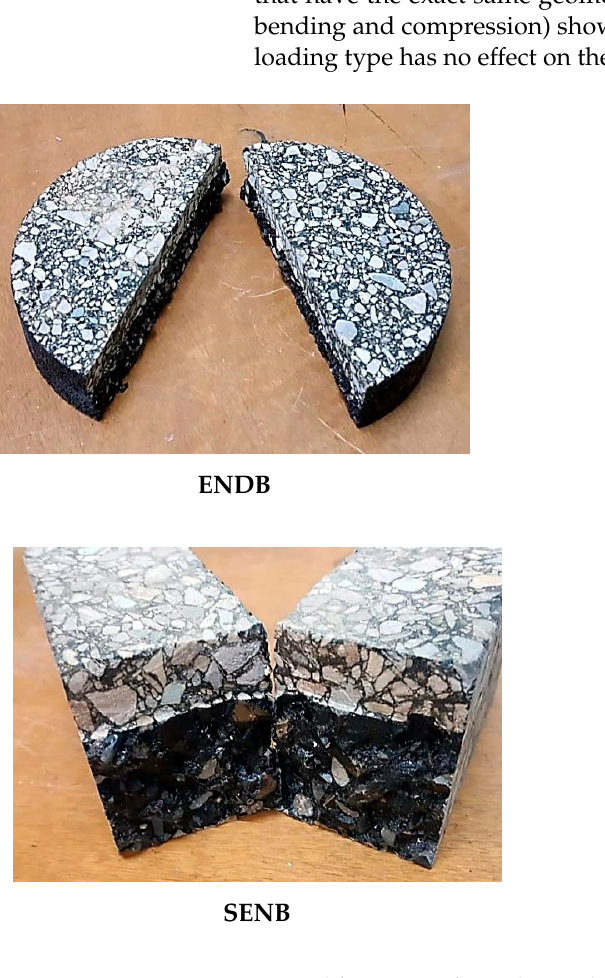
Figure 8. Typical load-displacement curves of the tested ENDB, SCB, SENB and ENDC specimens at − 25 °C. Table 3. Fracture loads of the tested specimens at low temperature conditions. Specimen Temperature ( °C )